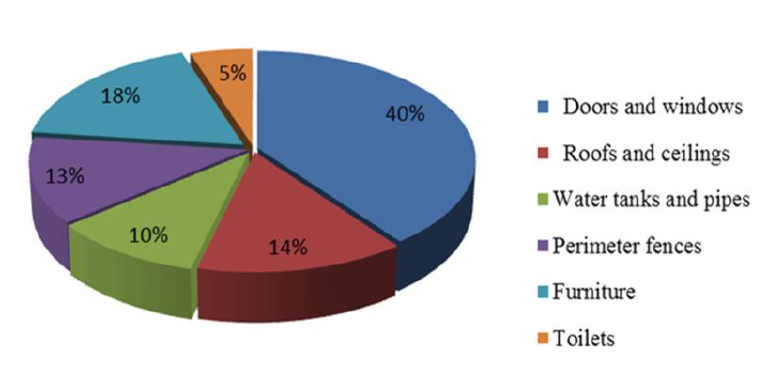
Figure 5: Percentage distribution of destructions in Schools in